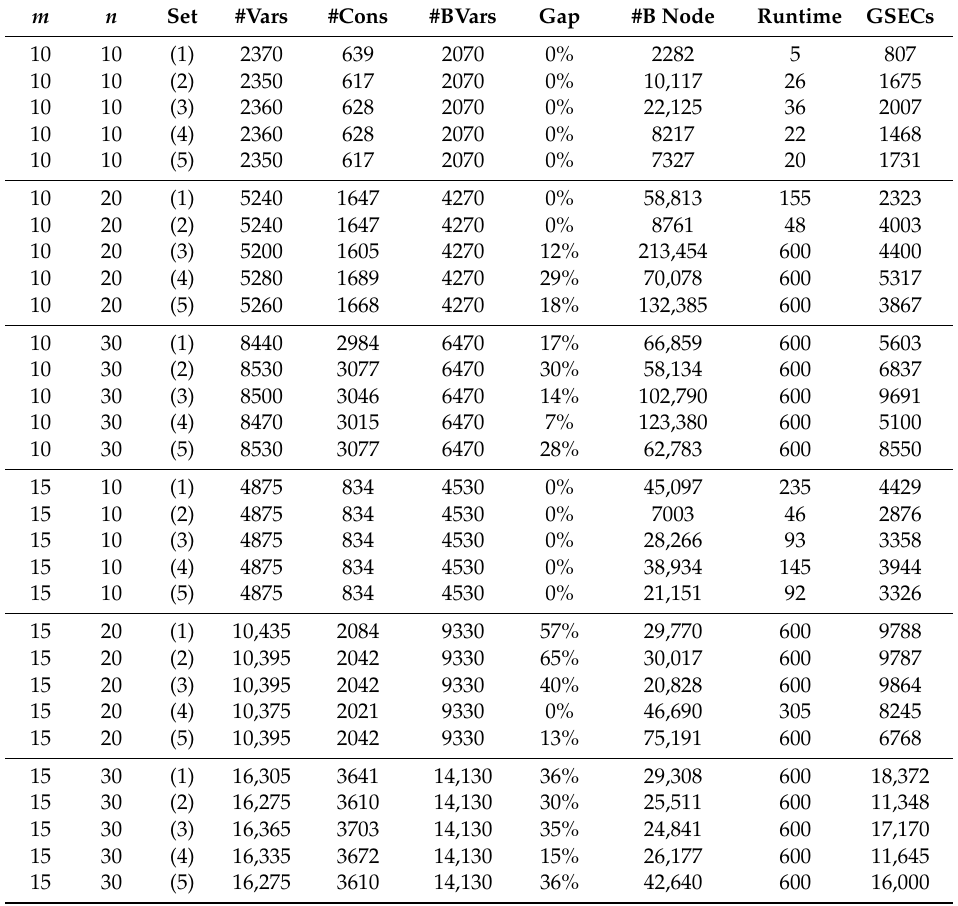
Table 4. Test results of M1 for instance group T.